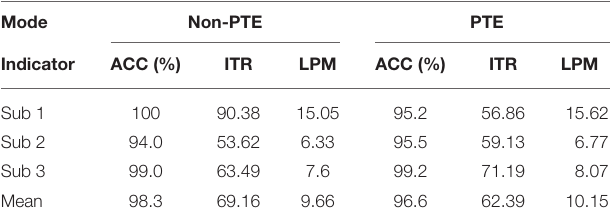
TABLE 2 | The spelling results between Non-PTE mode and PTE mode for all 3